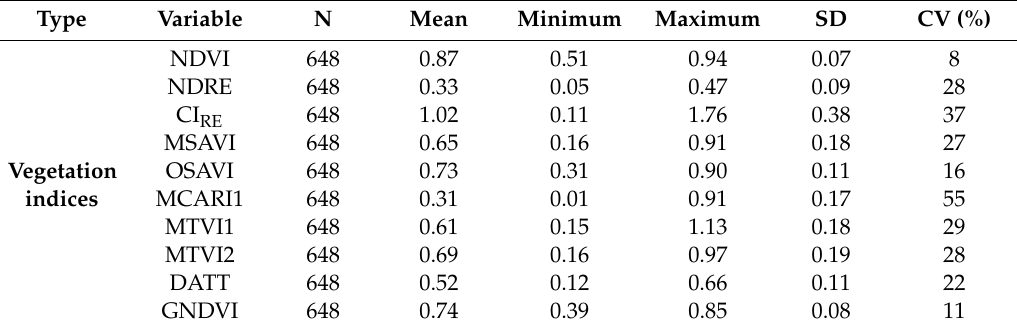
Table 4. Descriptive statistics of vegetation indices for the experiments in 2017 and